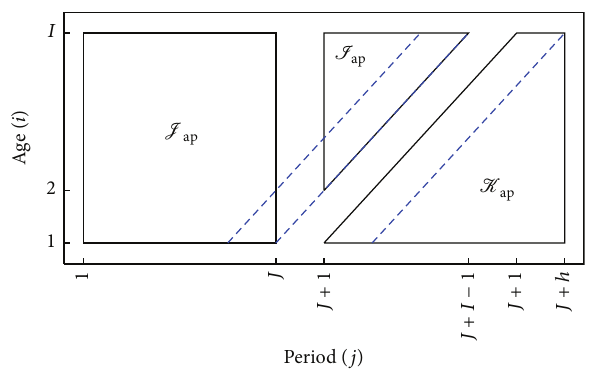
Figure 2: I is the data array. J is the forecast array where only ap ap ,1 period parameters need to be extrapolated. J 2 is the forecast array where both period and cohort parameters need to be extrapolated. Cohorts are indicated by dashed